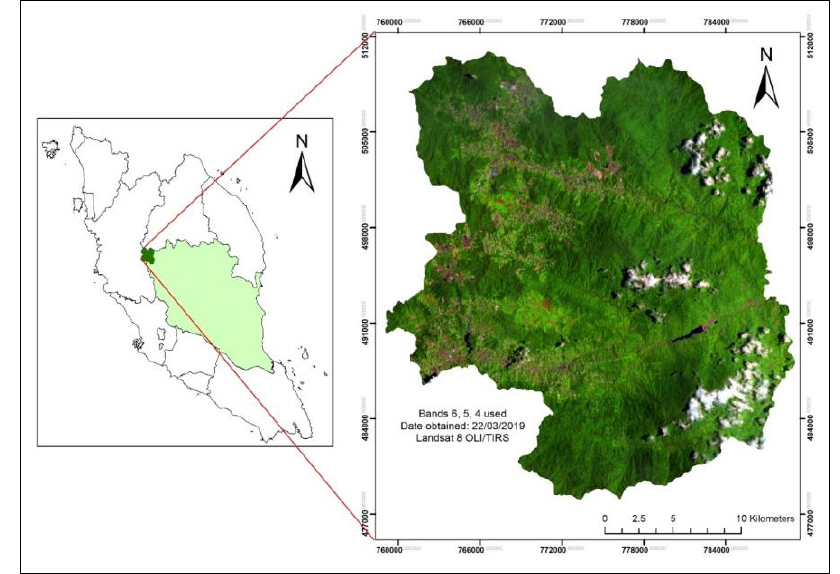
Figure 1. Study site of Cameron Highlands district (in the dark green shaded area), in the state of Pahang (light green), bordering Perak to the west and Kelantan to the north.